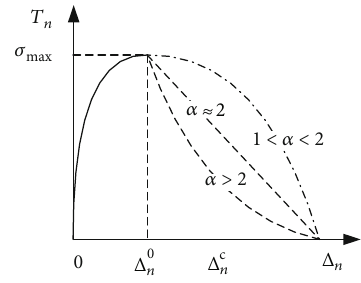
Figure 7: Response under di ff erent shape parameter α for pure mode I